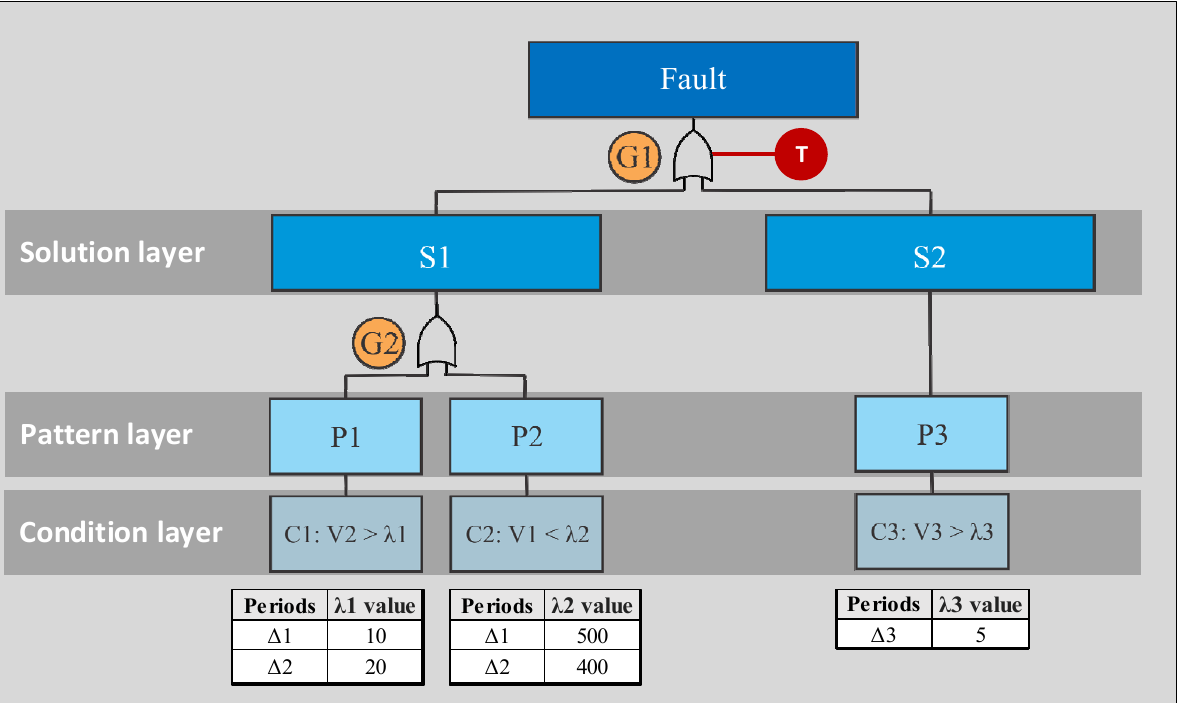
Figure 5. Time–OR gate functionality in the ITCA model.